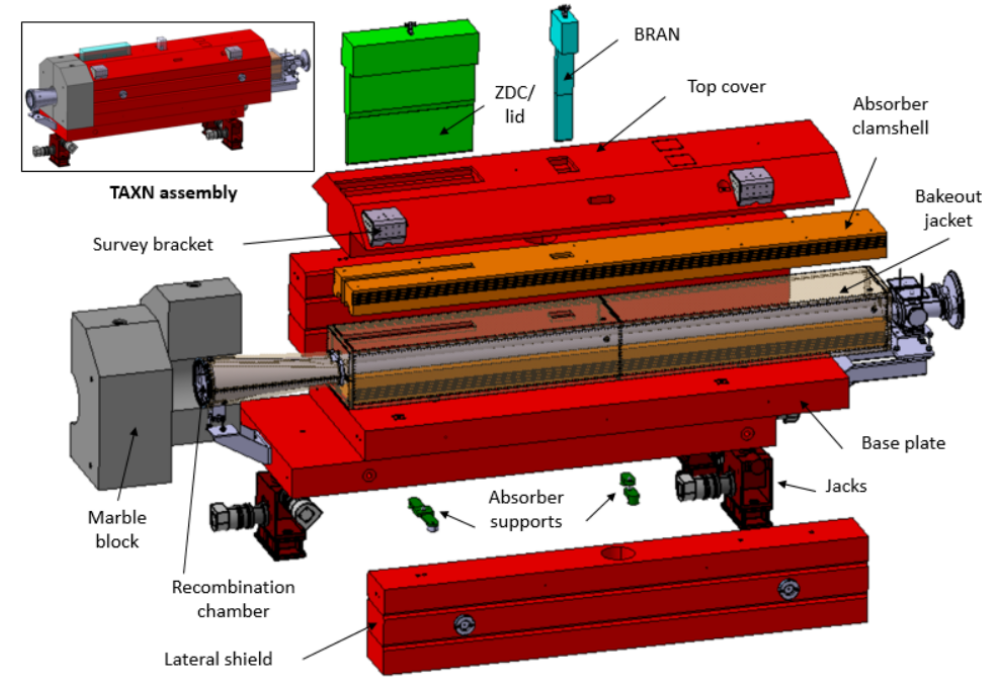
Figure 4. Exploded TAXN assembly. The TAN shares a very similar mechanical layout (longer copper